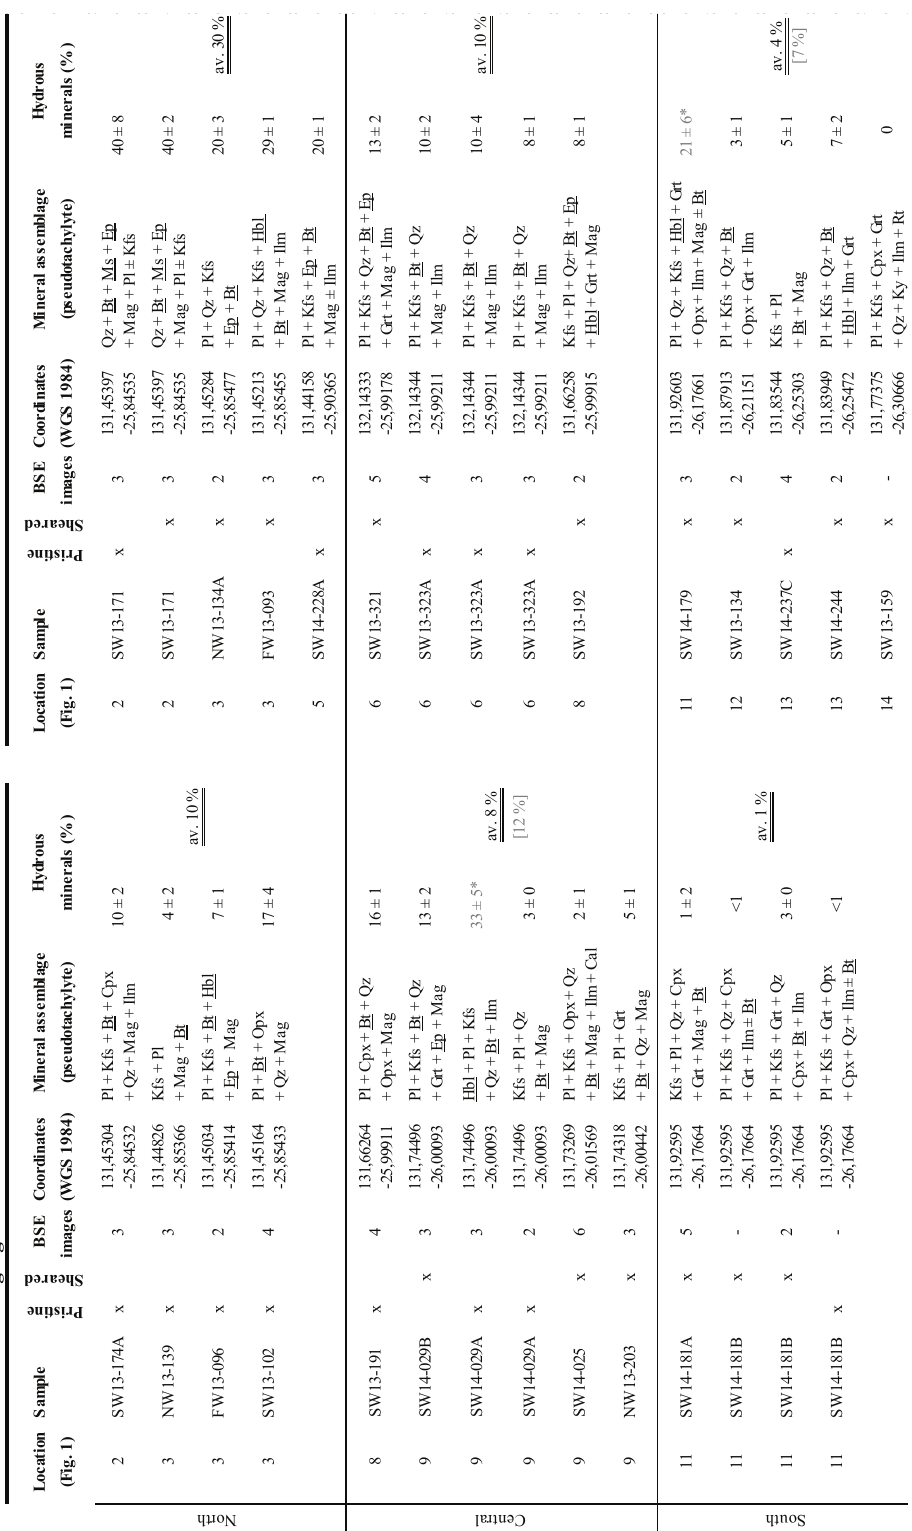
Table 4. Modal abundance of hydrous minerals in felsic pseudotachylytes from the hanging wall and footwall of the Woodroffe Thrust, central Musgrave Block. Extreme outliers ( ∗ ) are not considered. Mineral assemblages are listed in order of decreasing modal abundance (from left to right) with hydrous minerals underlined. A representative compilation of pseudotachylytes is given in Supplement Sect. S3. Errors given are 2 × standard